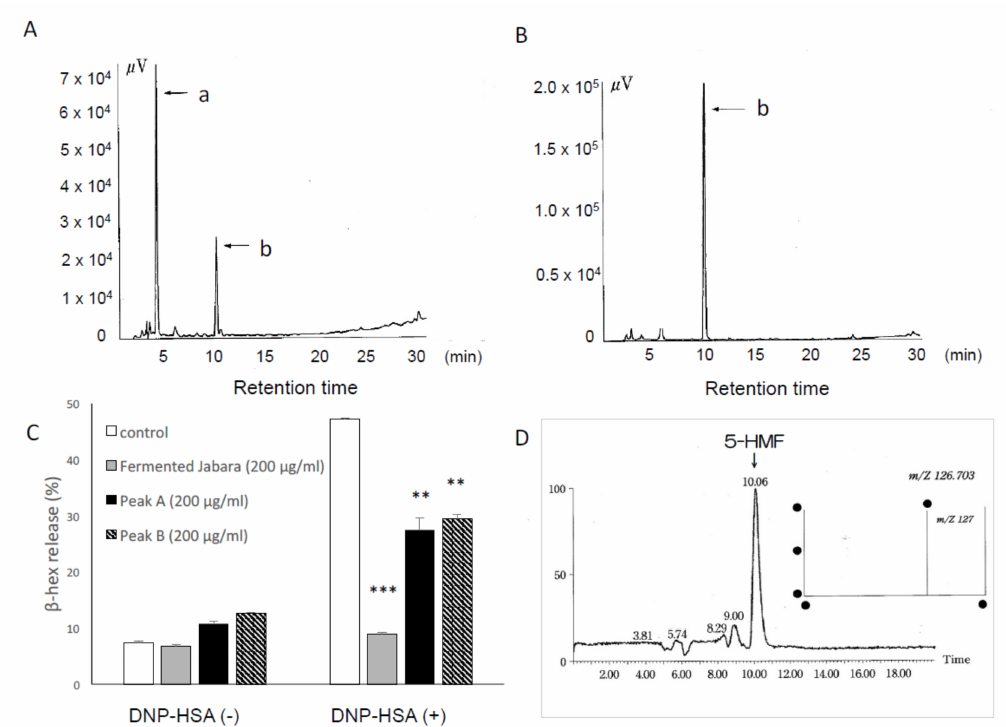
Figure 3. HPLC chromatograms of extracts (DMSO: MeOH = 1:1) of fermented Jabara ( A ) and flesh of Jabara ( B ). Column: ODS-HG-5 ( ϕ 4.6 × 250 mm, 5 µ m) NOMURA CHEMICAL; flow rate, 1.0 mL / min; detected with UV at 285 nm. ( C ) Inhibitory e ff ect of the compounds in peak a and b extracted from fermented Jabara on β -hex release from mast cells. IgE-sensitized mast cells (1.0 × 10 5 cells / well) were preincubated with each extract at 37 ◦ C for 15 min prior to 30 min stimulation with DNP-HSA. Data represent one of at least three trials that showed similar results. Data are presented as mean